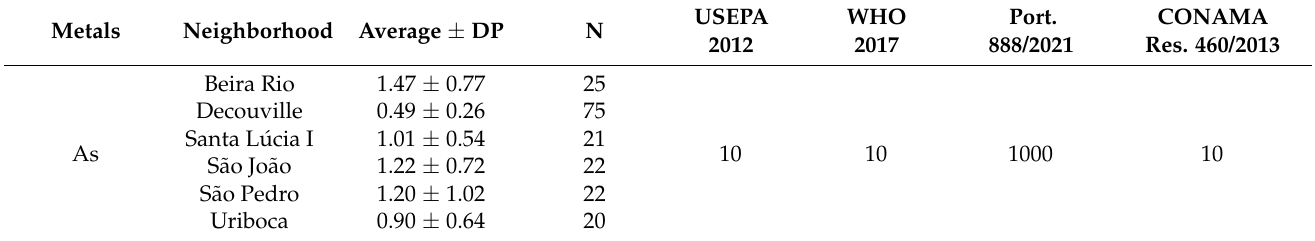
Table 4. Concentration of metals ( µ g.L − 1 ) in the groundwater of communities in Marituba, Par á